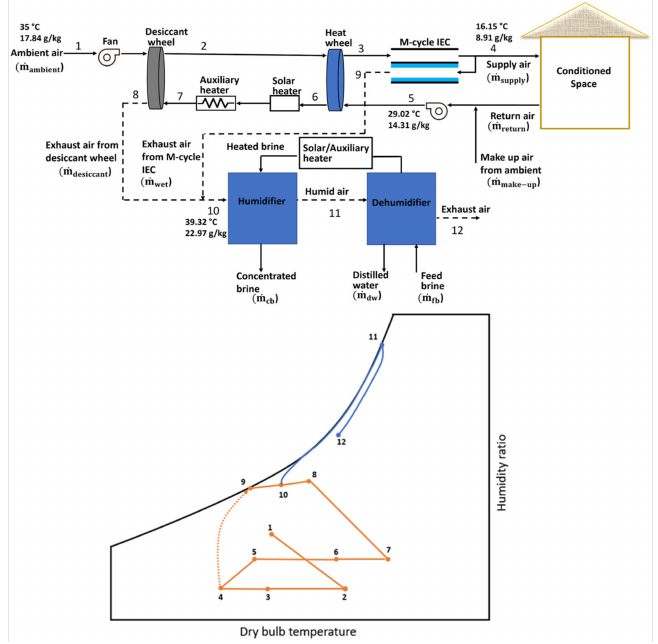
Figure 1. Schematic and psychrometric diagram of SDM-HDH in ventilation